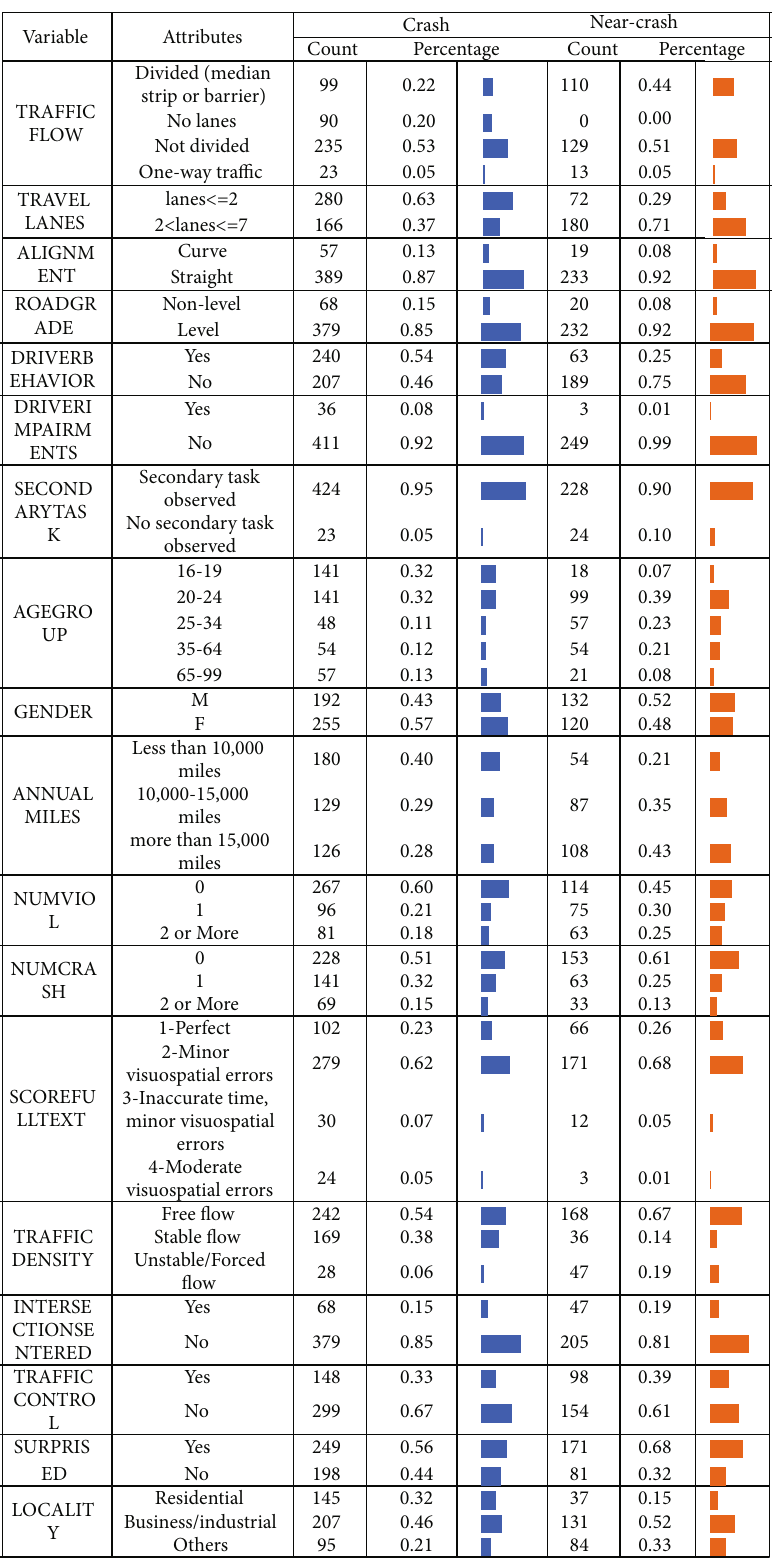
Figure 2: Distribution of